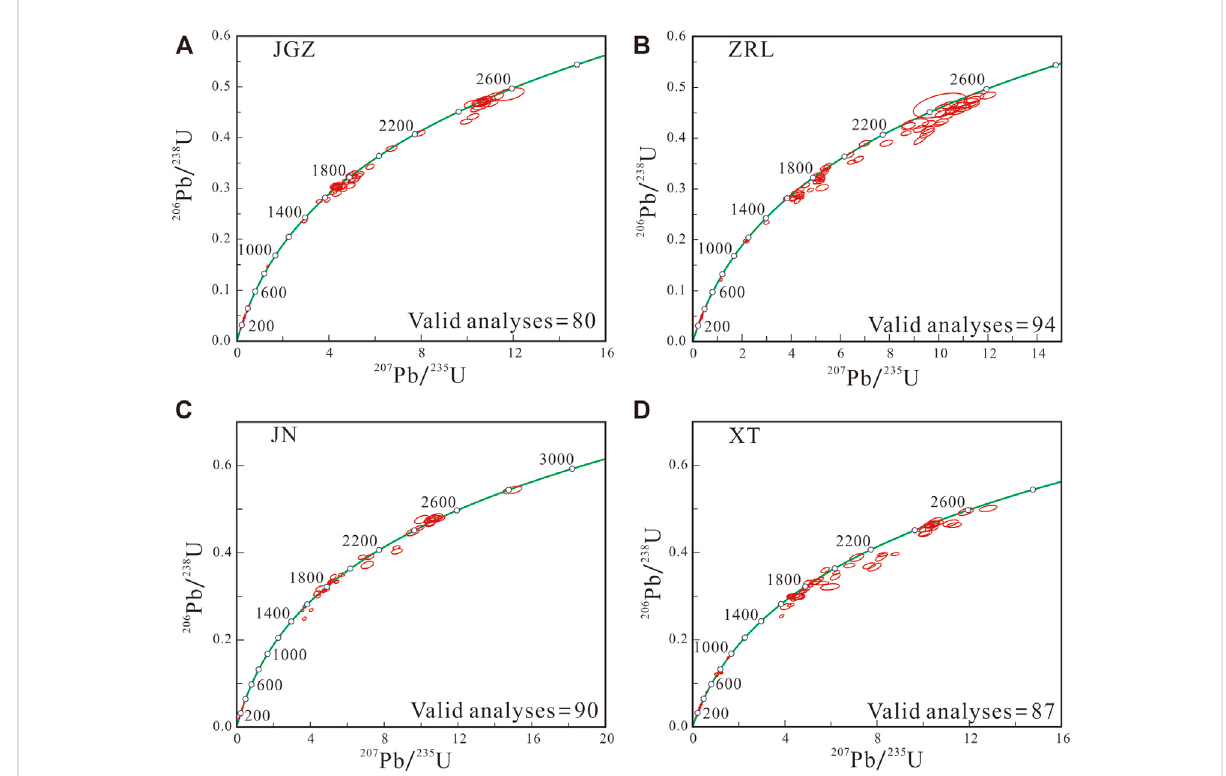
FIGURE 7 Zircon U-Pb Concordia diagrams for detrital zircon grains from the Late Mesozoic sedimentary